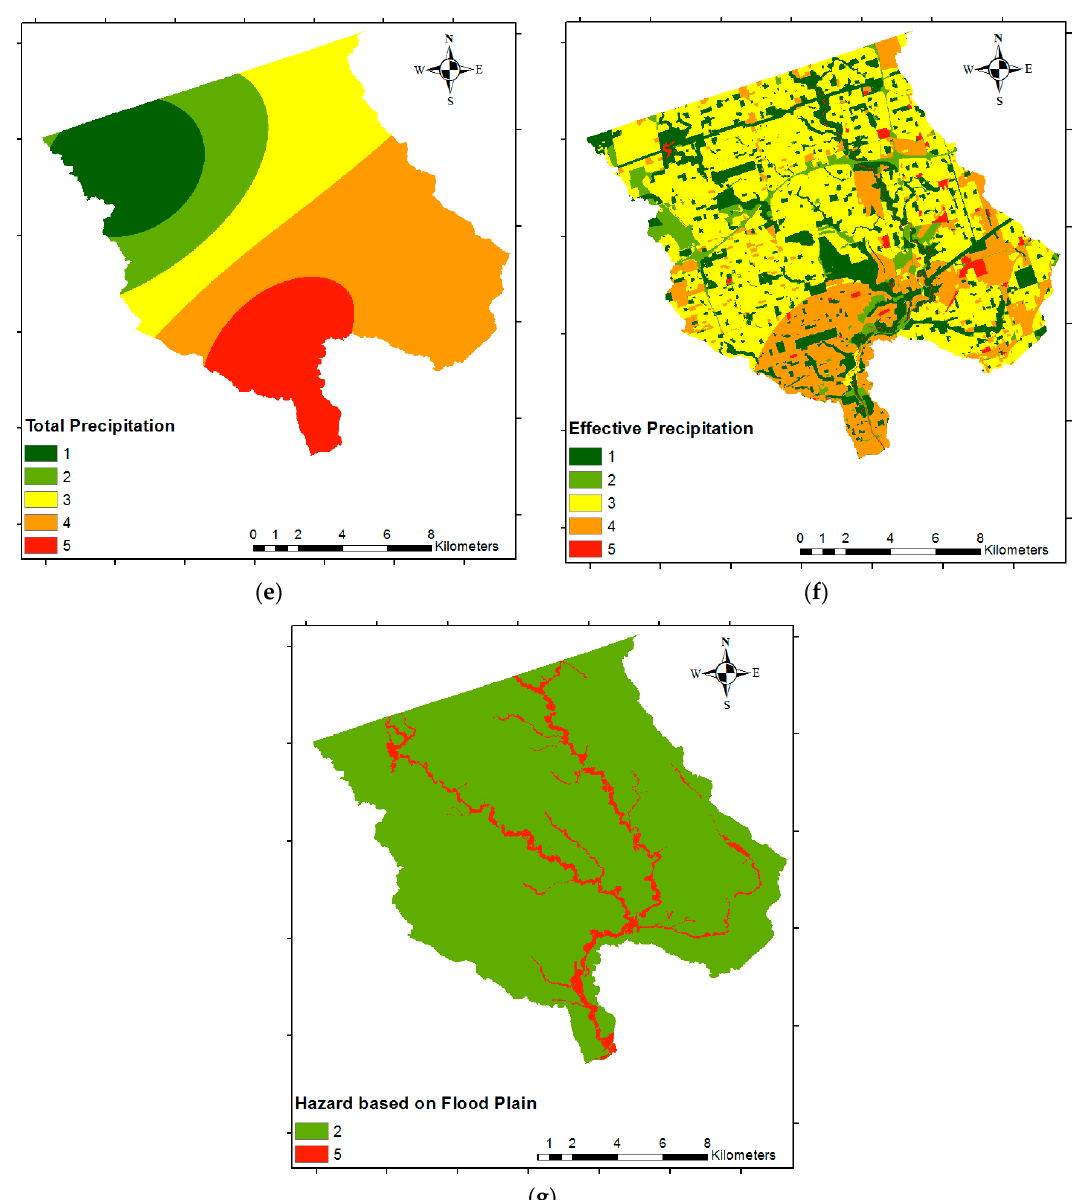
Figure 4. Flood hazard criteria reclassified; ( a ) slope; ( b ) height above the nearest drainage; ( c ) distance to streams; ( d ) Curve Number; ( e ) total precipitation; ( f ) effective precipitation; ( g ) floodplain.